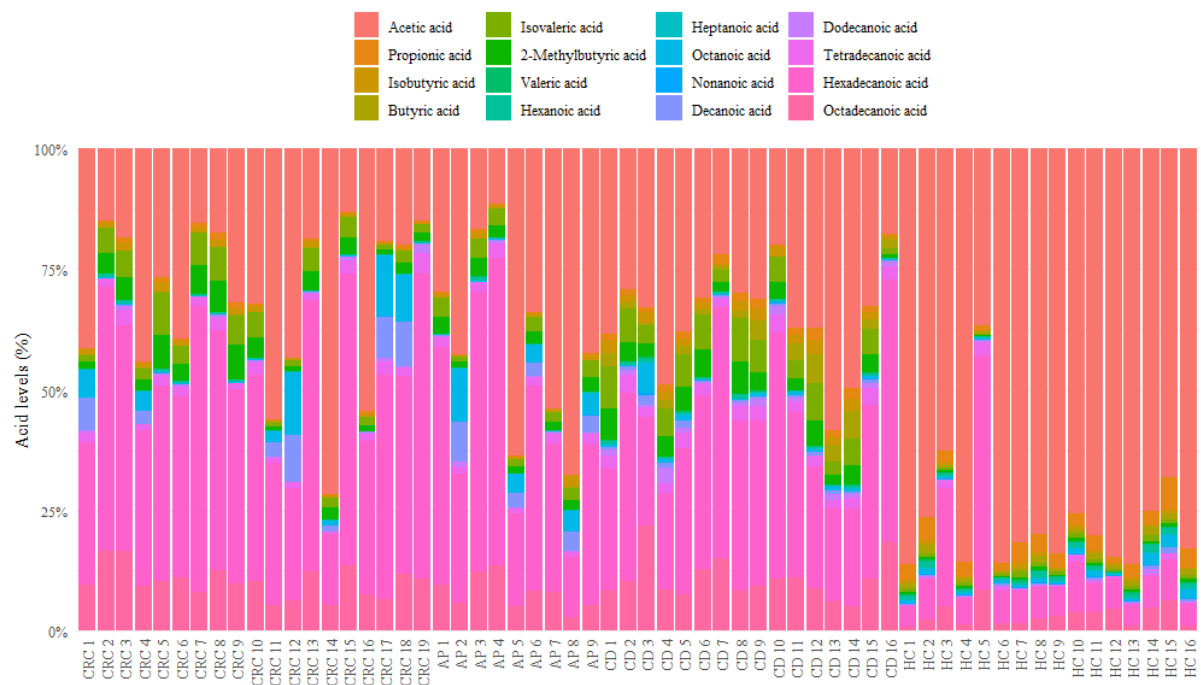
Figure 1. Bar plot of relative abundances of each serum FFA of CRC, AP, CD patients and healthy controls. FFA = free fatty acid; HC = healthy controls; CD = celiac disease; AP = adenomatous polyposis; CRC = colorectal cancer.